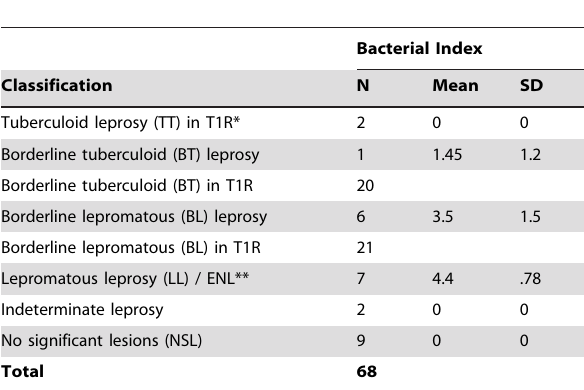
Table 4. Histological classification of nerve biopsies.